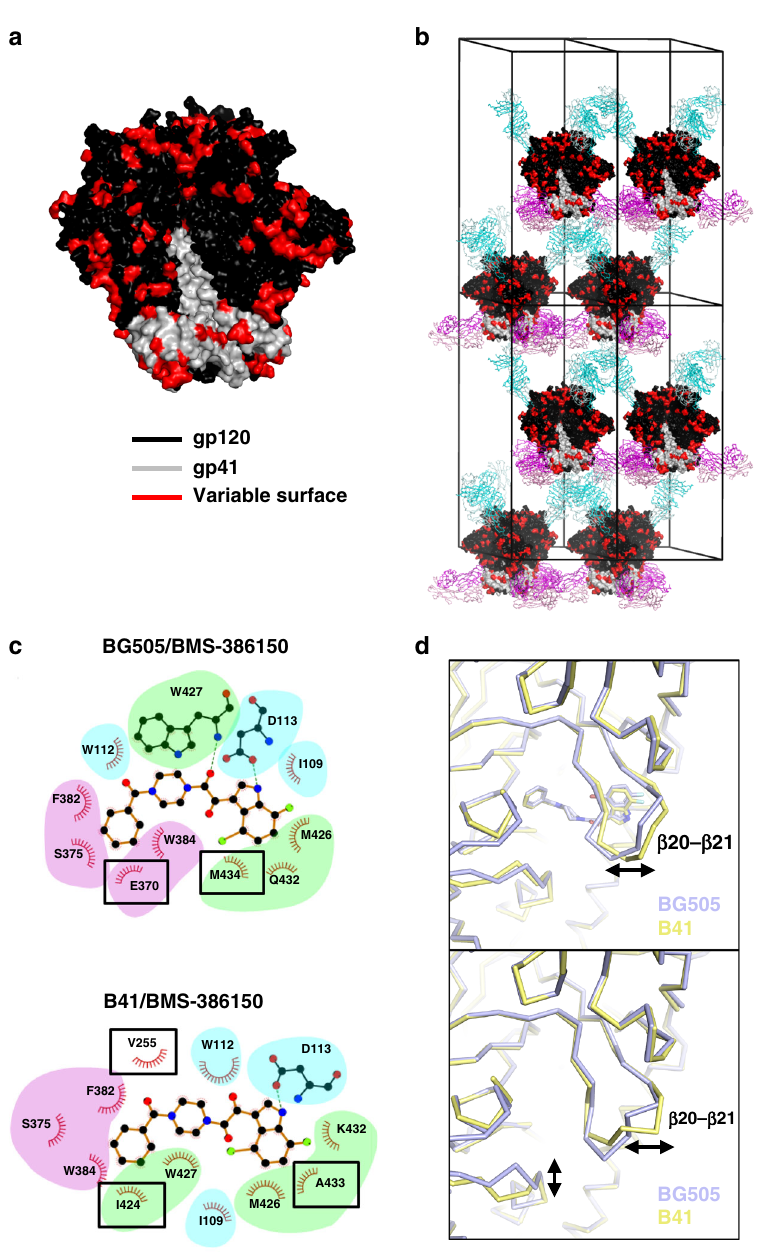
Fig. 5 Generalizable crystallization platform for diverse HIV-1 envelope and drug complexes. a B41 SOSIP.664 Env trimeric structure in surface representation shows gp120 in black and gp41 in gray; the residues that differ between the B41 SOSIP.664 and BG505 SOSIP.664 Env trimers are colored as red. b B41 SOSIP.664 Env trimeric structure is shown in the context of P6 3 lattice. c Structures of BMS-386150 in complex with the BG505 (top) or B41 (bottom) SOSIP.664 Env trimers. Residues interacting with BMS-386150 that are different between B41 and BG505 are highlighted in black box. d The backbone conformational differences in the structures of BMS-386150 complexed with BG505 (purple) or B41 (yellow) are shown as ribbon diagram (top), the same region in the apo-form BG505 and B41 are also shown